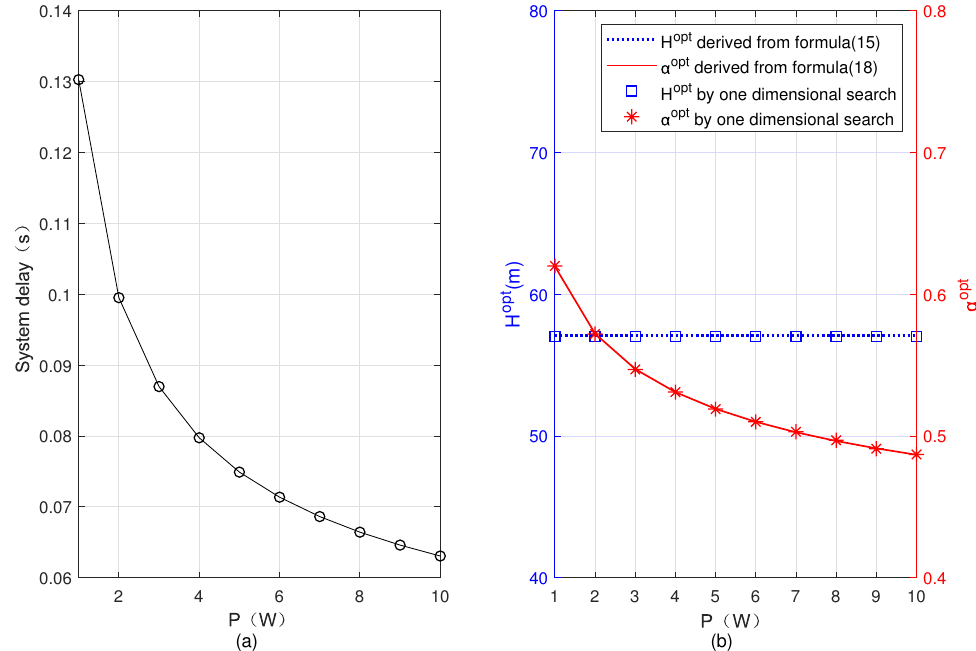
Figure 3. Minimum system delay, optimal flying altitude, and optimal task allocation ratio versus transmit power of the user. ( a ) Minimum system delay, ( b ) optimal flying altitude and optimal task allocation